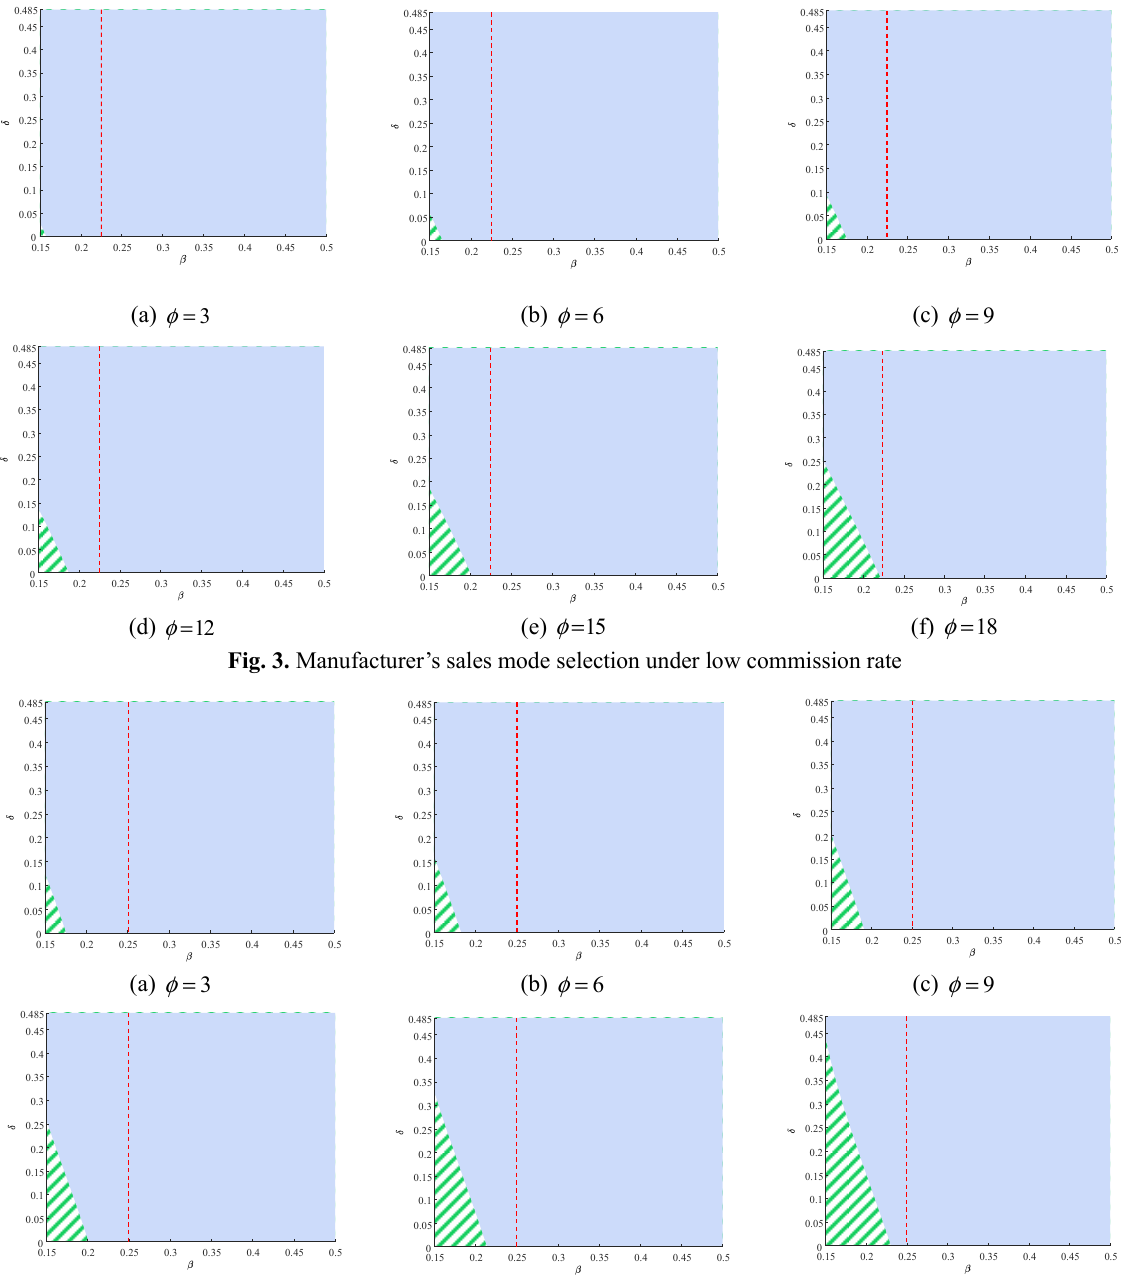
Fig. 3. Manufacturer’s sales mode selection under low commission rate